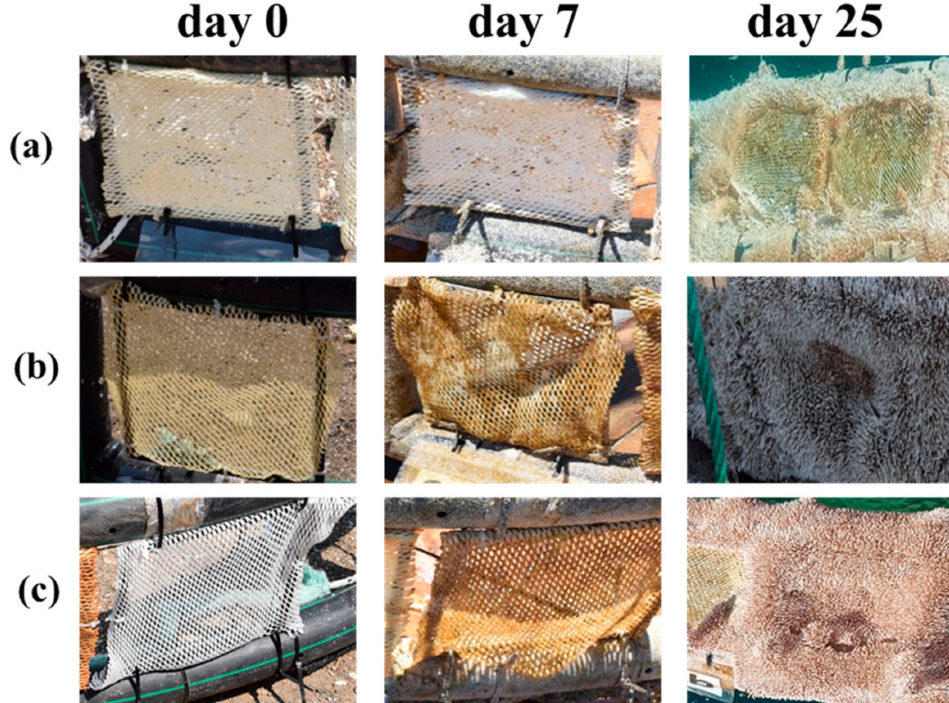
Figure 5. Photographs of the nets coated with P(SSAmC 16 -co-VBCHAM30) ( a ), P(SSAmC 16 60-co-VBCHAM20-co- GMA20)/PAA ( b ), and uncoated net ( c ) at the beginning of the immersion (t = 0 d) and after 7 d and 25 d of immersion in the sea